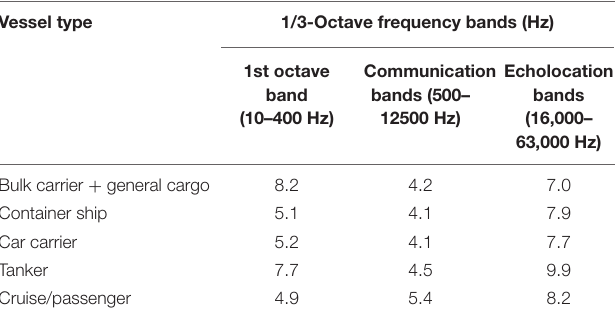
TABLE 1 | Power-law scaling coefficients of monopole source level (SL) versus speed ( C v ) for the bulk carrier and general cargo, container ship, car carrier, tanker, and cruise/passenger vessel